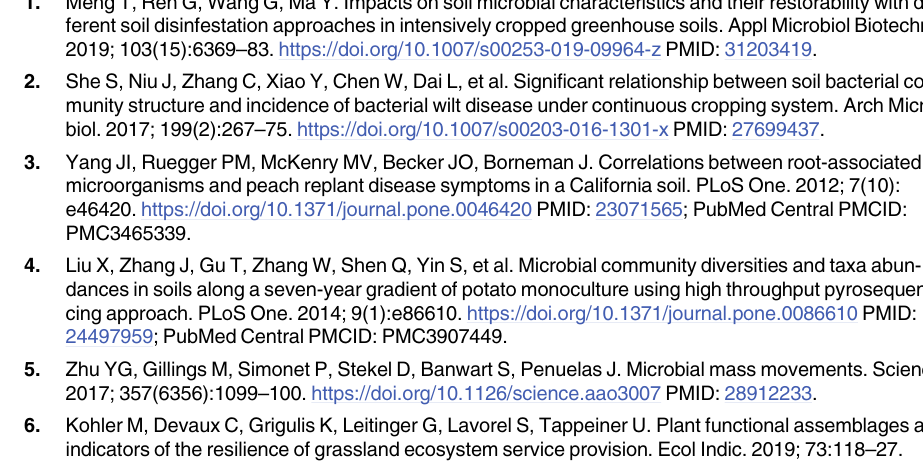
S1 Fig. Venn diagrams of OTU changes of the CK group and O changes were recorded at 0, 1, 3, 5 and 9 days. CK: control group; O treatment group. (TIF) S2 Fig. The dilution curve of samples. (A-E) The dilution curve at 0, 1, 3, 5 and 9 days. CK: Control group; O : The OW disinfestation treatment group. Five replicates in each group. 3 (TIF) S3 Fig. Microbial community relative abundance at genus level at 0, 1, 3, 5 and 9 days after OW disinfestation treatment and exposure to air. (TIF) S4 Fig. Venn diagrams of differential biomarkers at various days. (A) Venn diagram of the O group differential biomarkers at 0, 1, 3, 5 and 9 days. (B) Venn diagram of the CK group 3 differential biomarkers at 0, 1, 3, 5 and 9 days. CK: Control group; O treatment